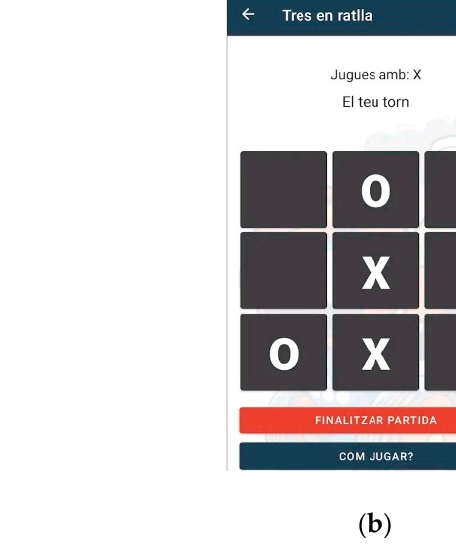
Figure 8. Interfaces to play with Lab2 Qui-Bot: ( a ) connect four and ( b ) tic-tac-toe.